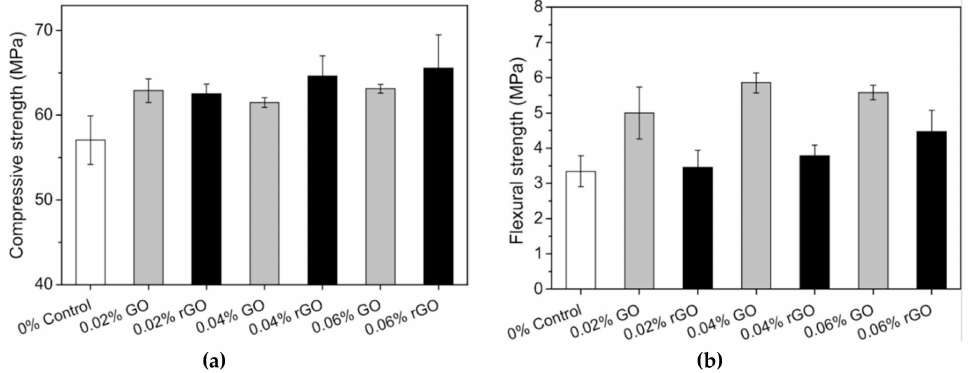
Figure 32. Experimental response of the ( a ) compressive and ( b ) flexural strength of GO and rGO reinforced cement specimens at curing age of 28 days. Reprinted with permission from [162]. Copyright © 2019, Elsevier